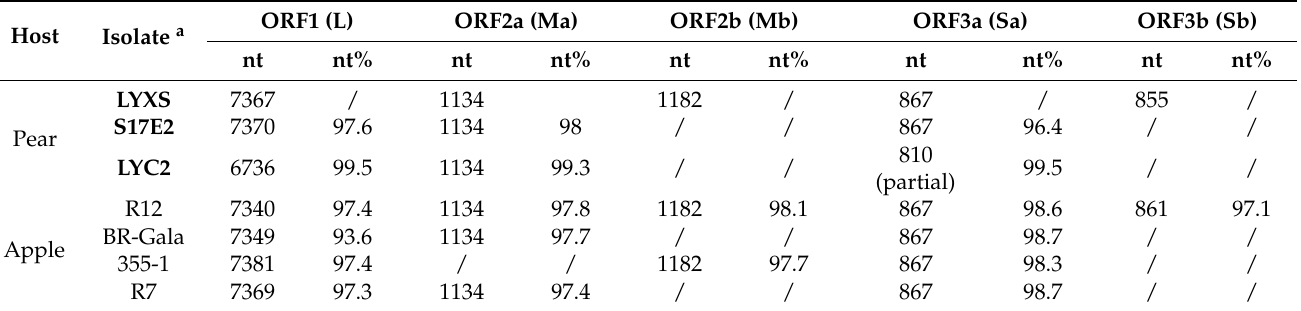
Table 2. RNA sequence comparison of ARWV-2 isolates with that of an isolate LYXS determined in this